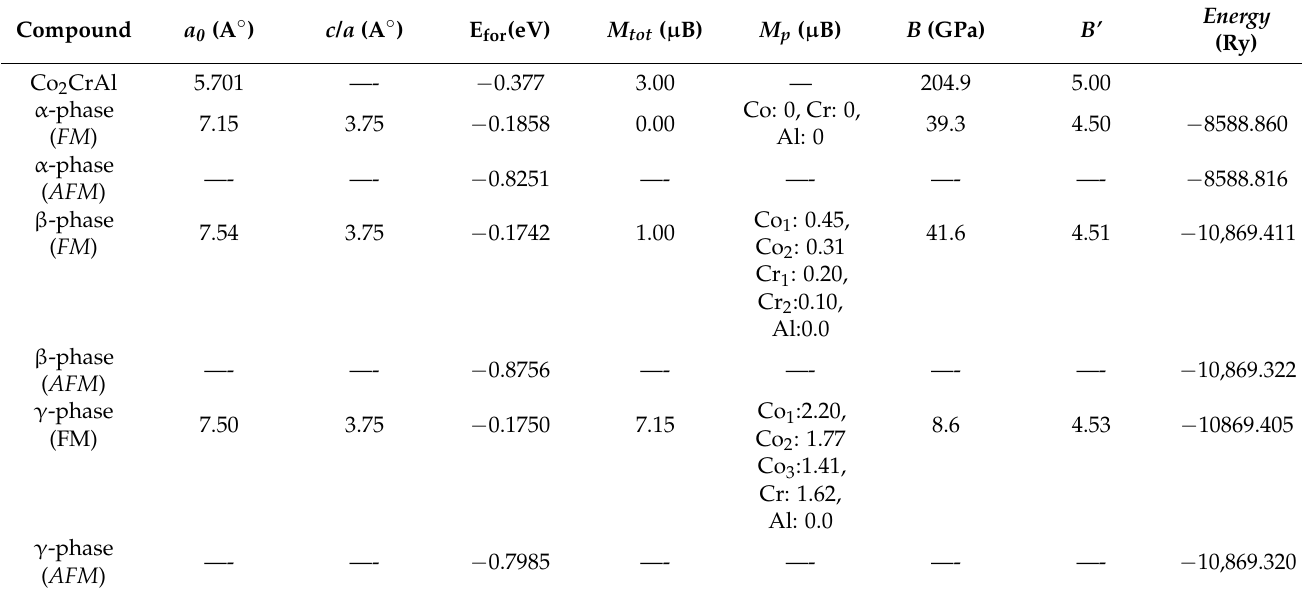
Table 1. Structural and mechanical properties of Co 2 CrAl compound in the bulk and three Heuslerene phases, including: crystal lattice constants (a, c), formation energy (E for ), total magnetic moment (M tot ), partial magnetic moment (M p ), Bulk modulus (B), and derivative bulk modulus (B ’